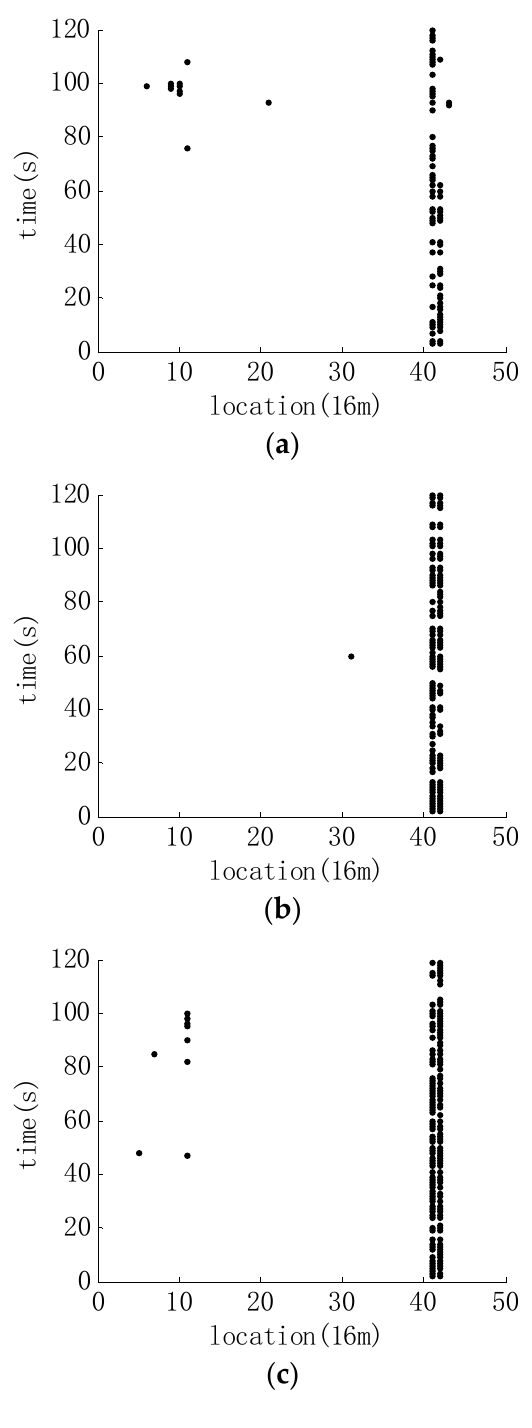
Figure 11. The detection results of mechanical drilling signals. ( a ) The first group of mechanical drilling signals; ( b ) The second group of mechanical drilling signals; ( c ) The third group of mechanical drilling signals.